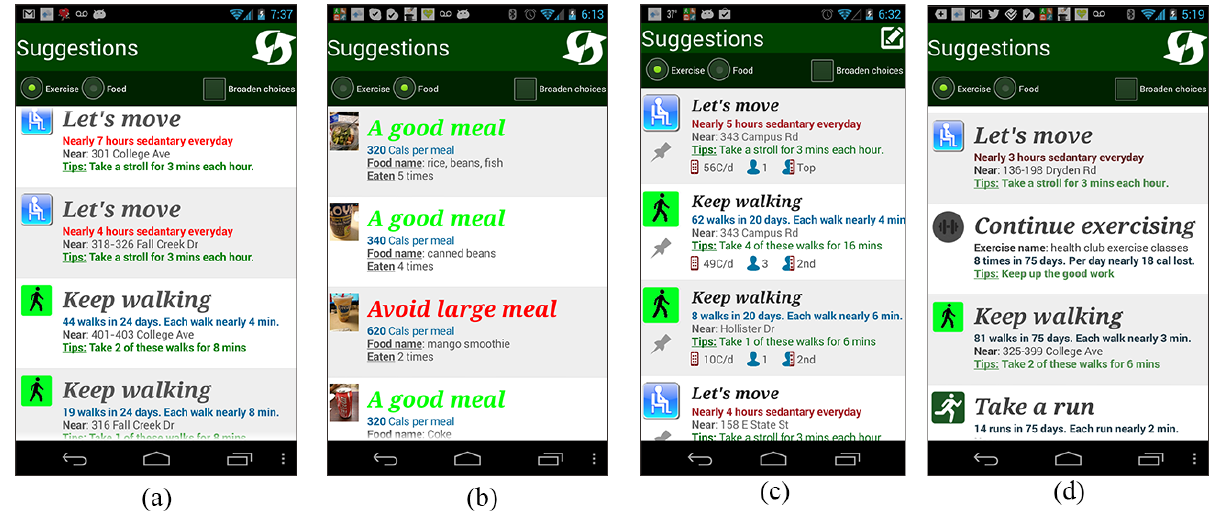
Figure 4. Screenshots showing recommended suggestions for exercise and food: (a) physical activity suggestions made by MyBehavior, (b) food suggestions made by MyBehavior, (c) physical activity suggestions for a different user, and (d) physical activity suggestions for the same user as in (a), but at a different point in